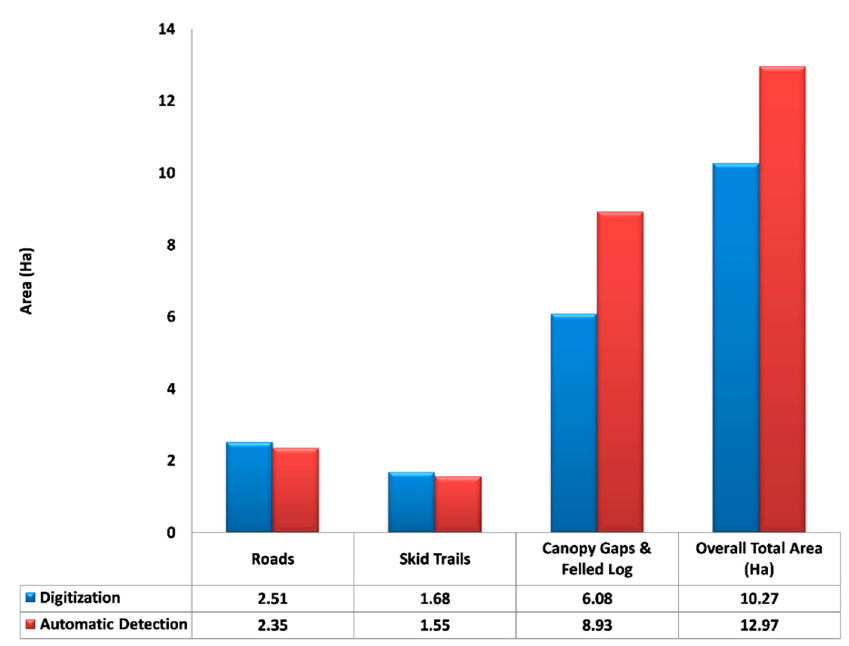
Figure 17. Area comparison between automatic and manual detection methods in detecting roads, skid trails and forest canopy gaps area.